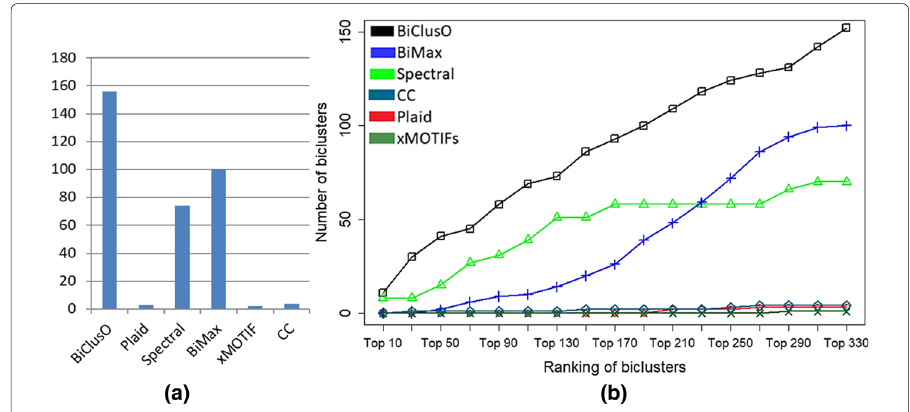
Fig. 5 a Number of biclusters generated by different algorithms. b Performance of different algorithm on Species VOC data